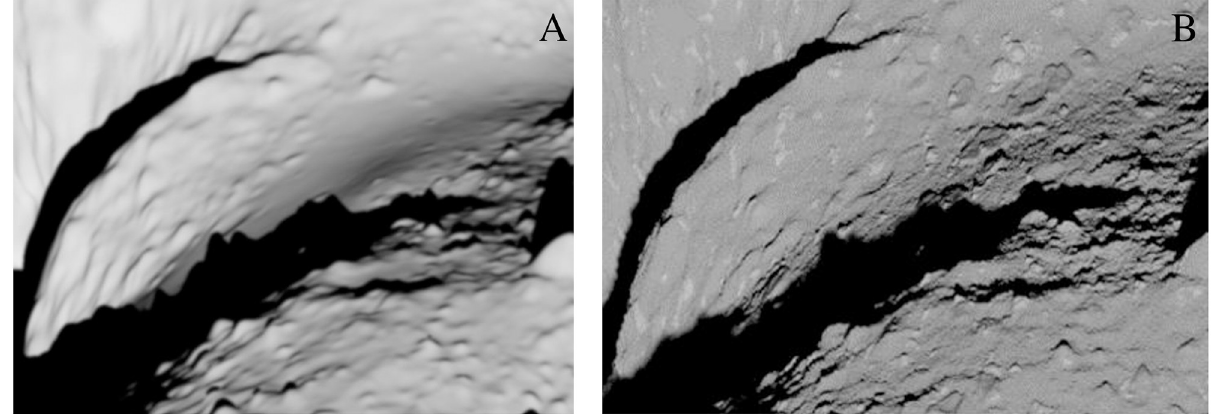
Fig 8. Close view of the 25143 Itokawa surface. Zoomed-in region. (A) OpenGL render and (B) Cycles render.